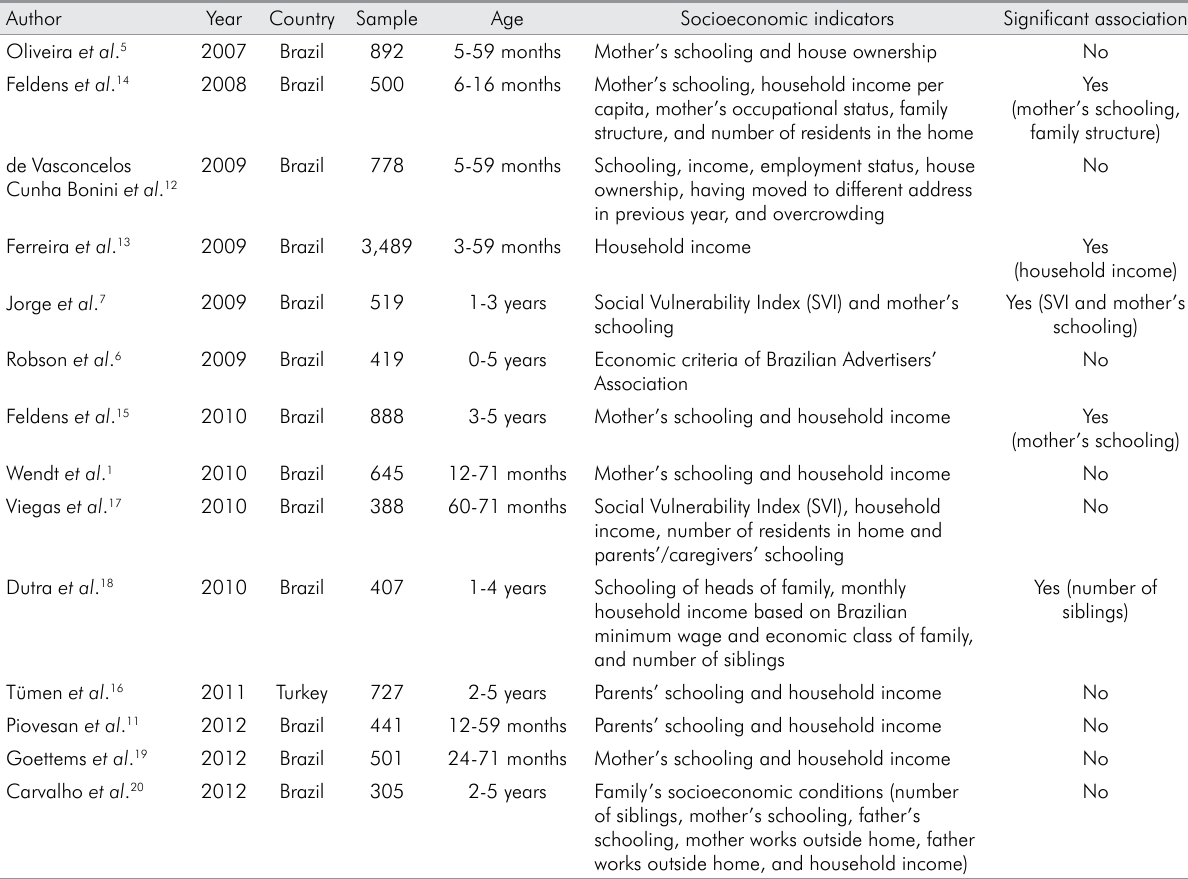
Table 1. Studies on associations between TDI in deciduous teeth and characteristics of child, socioeconomic indicators and clinical